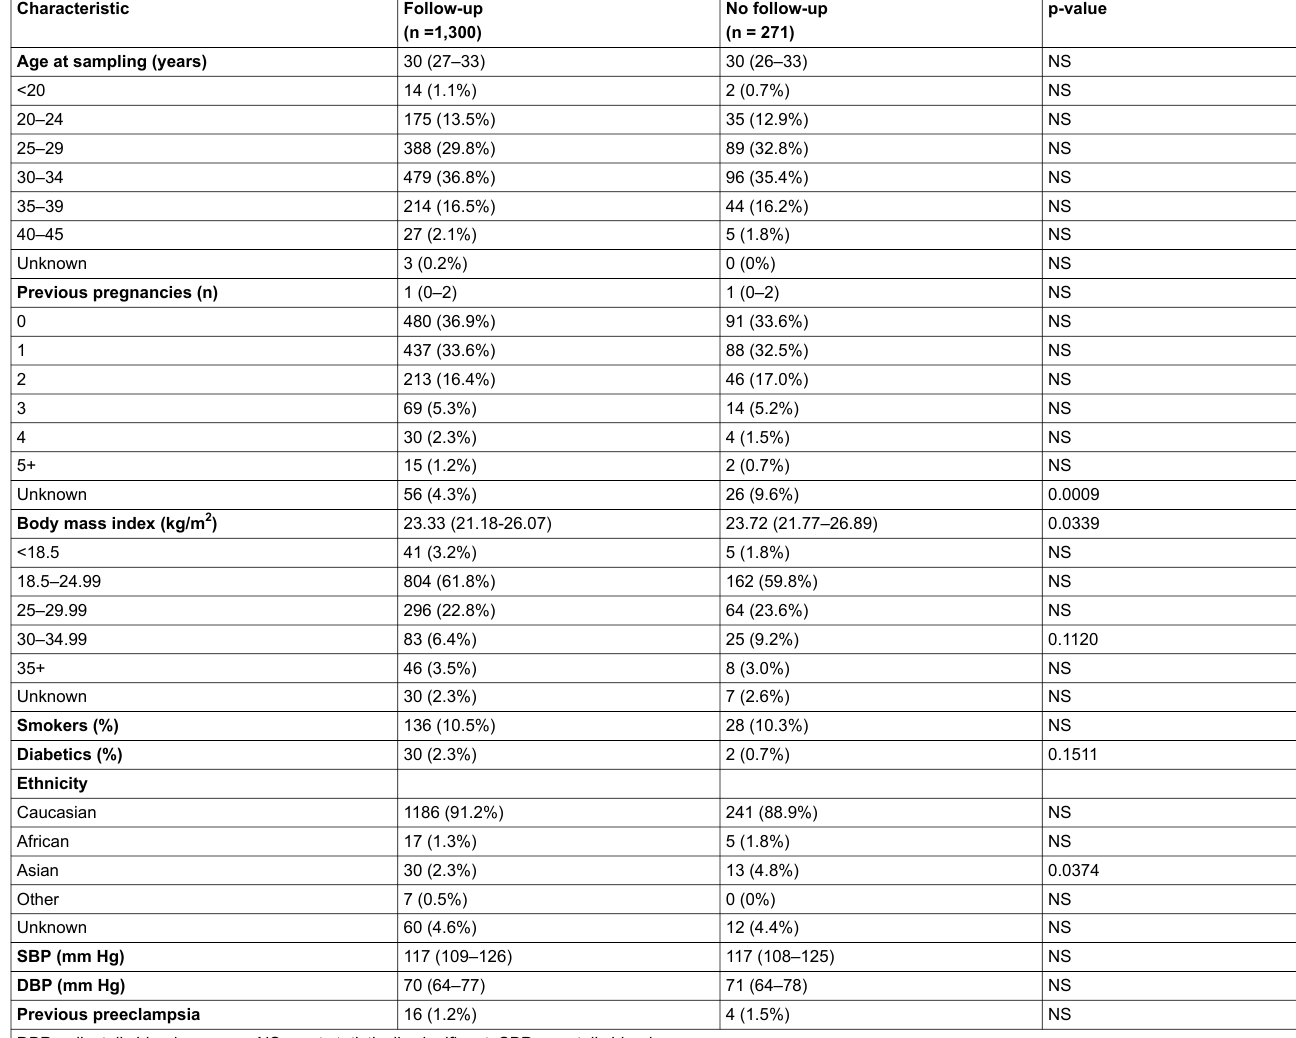
Table 1: Maternal characteristics presented as median (interquartile range) or number of pregnancies (percentage) in women with and without follow-up. Characteristics were obtained from pregnancies at gestational age 10+3 until 13+6 weeks.